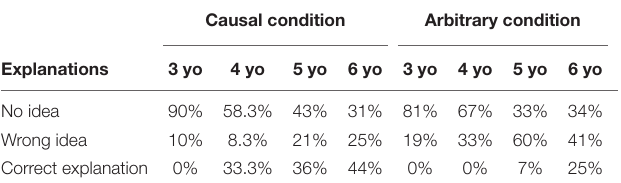
TABLE 2 | Percentage of children who gave the following explanations in response to the question "How did you know where the ball was?" in Experiment 1 ( N =